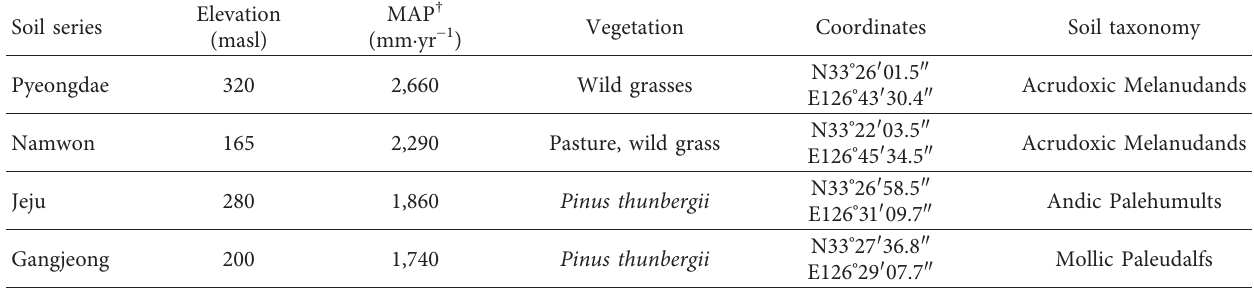
Table 1: Site characteristics of the four investigated soil profiles derived from pyroclastic materials in Jeju Island, Korea. Soil series